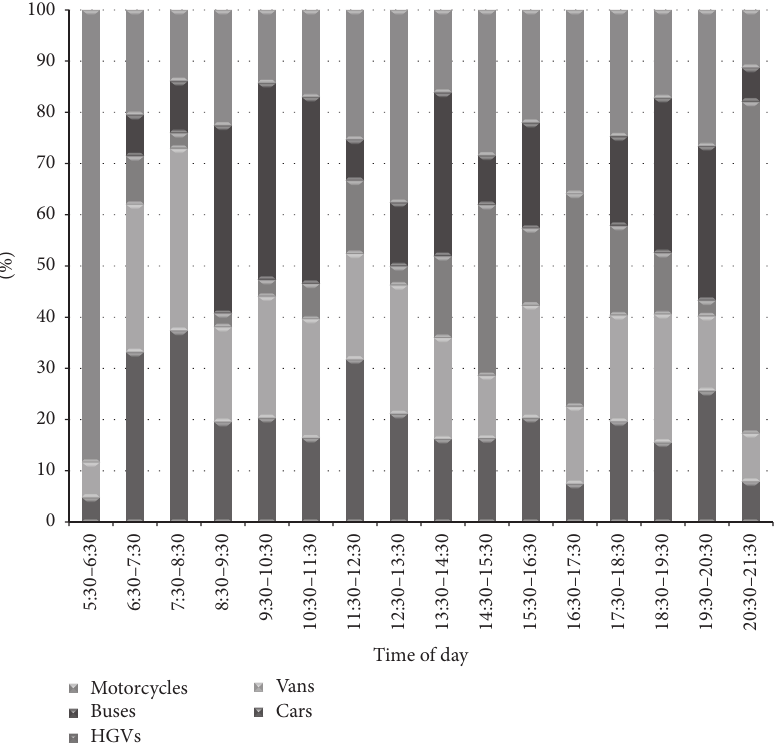
Figure 8: Departure rate of wheeled vehicles crossing the Strait of Messina.